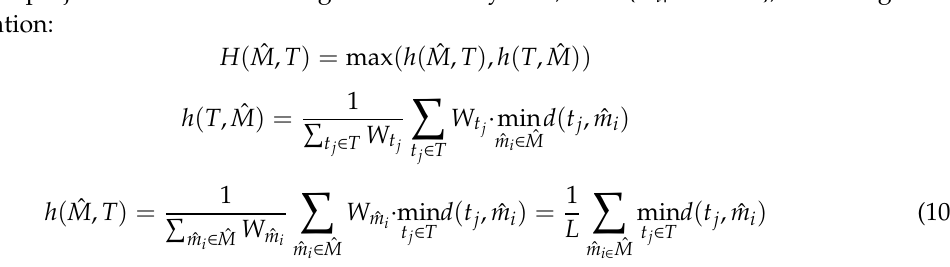
to line 𝑚 under different conditions (cid:3037) (cid:3037)